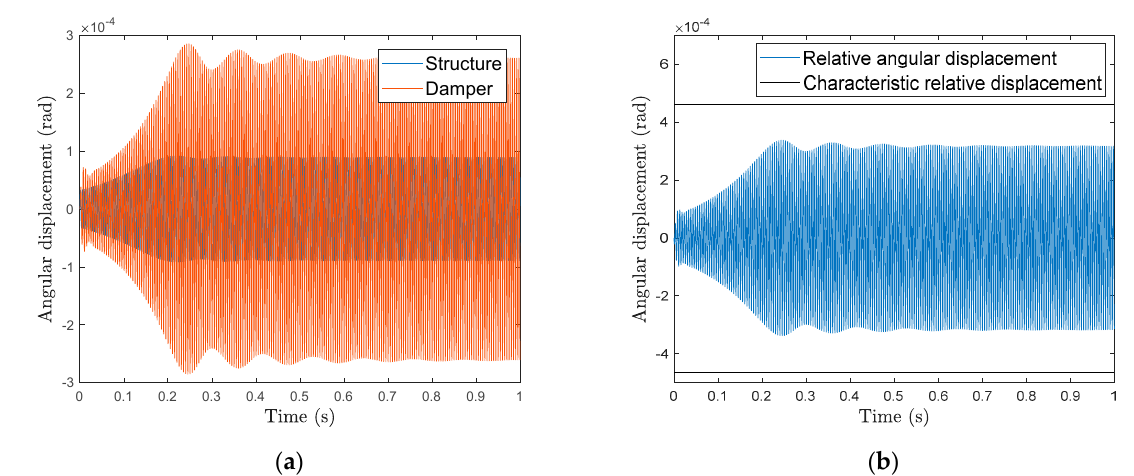
Figure 10. Time domain results for an instability of D i = − 1%. ( a ) Angular displacement of the drill string structure and the damper. ( b ) Relative angular displacement between the damper and the drill string structure.